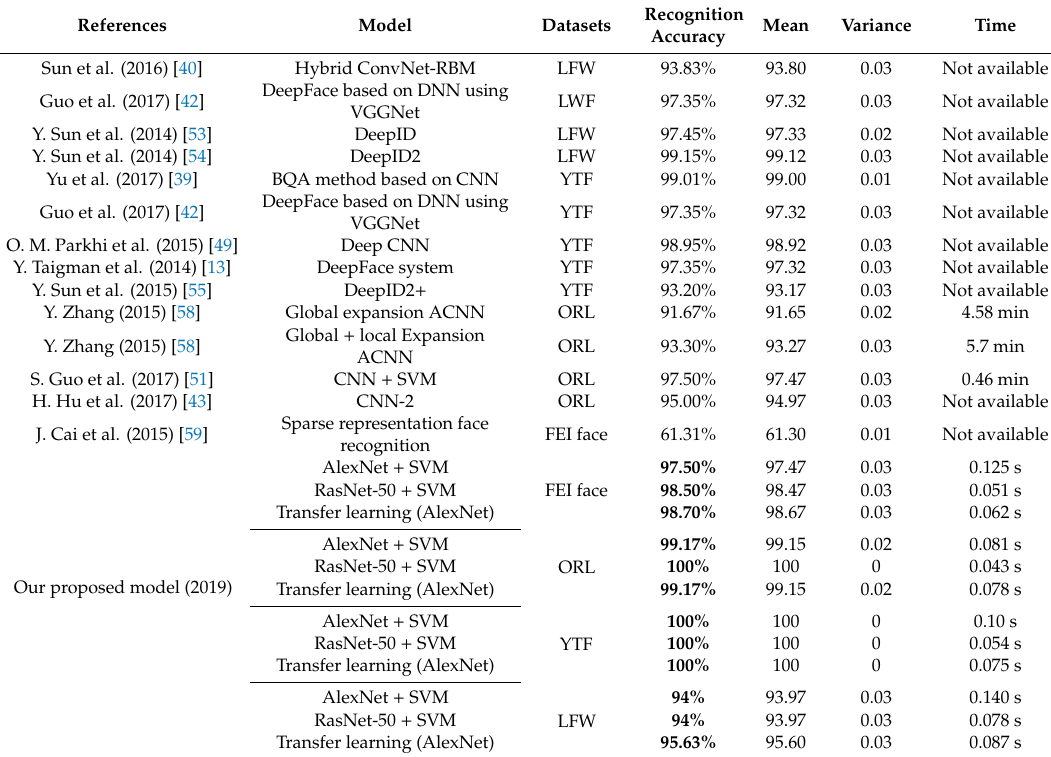
Table 6. Comparison of results with other face recognition (FR)